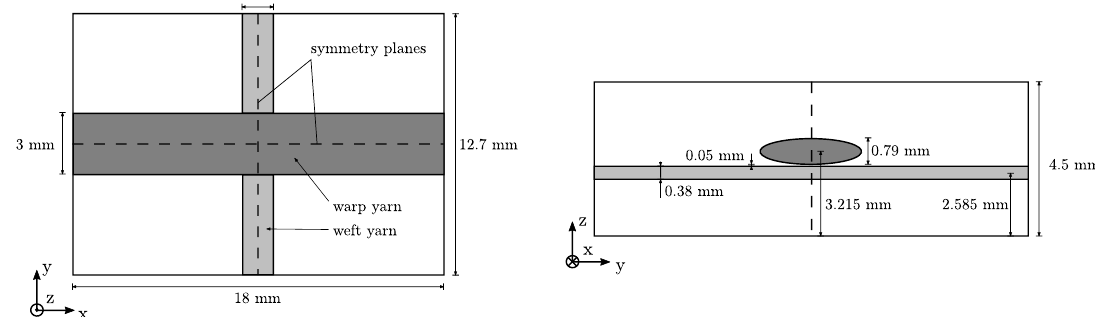
Figure 3. Geometry of a single layer TRC-RVE: top view ( left ), side view ( right